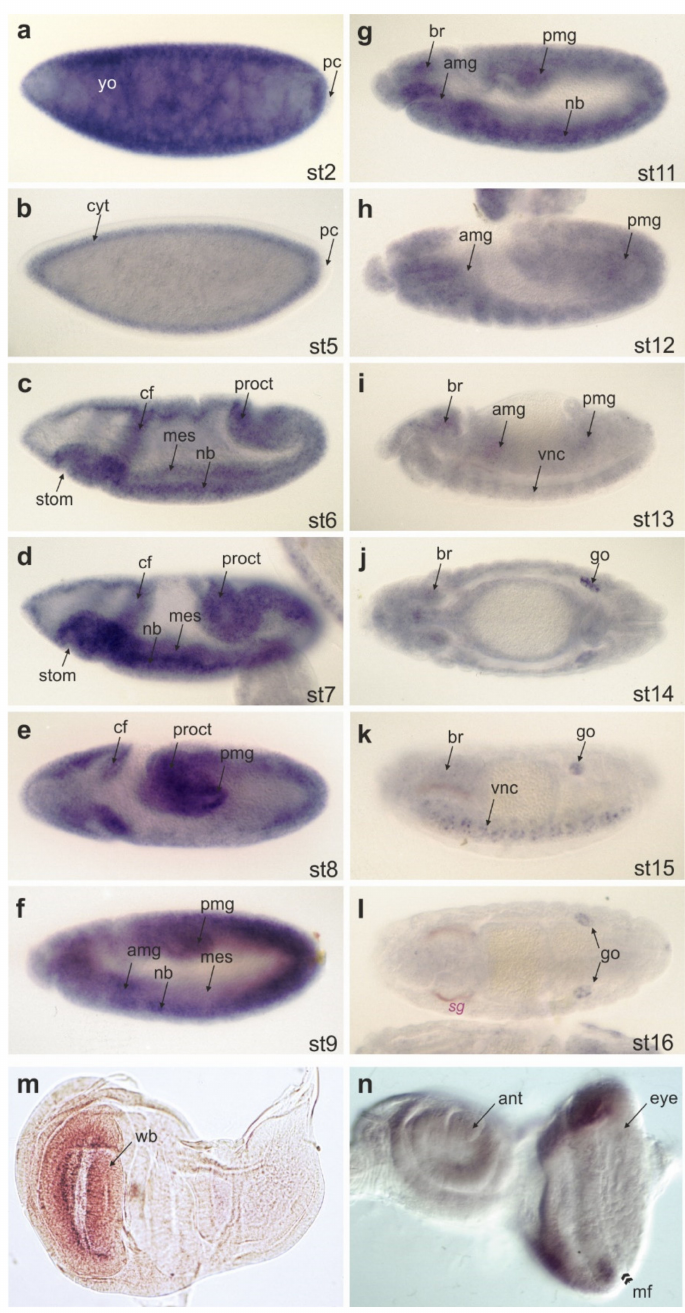
Figure 4. Expression of CG32521 during development. In situ hybridization to detect CG32521 transcription during development. ( a – l ) Embryos are oriented anterior to the left and dorsal up except for the top view in ( j ) and ( l ); developmental stages (st) are indicated. Note enrichment in the yolk (yo) ( a ), the mesoderm (mes) ( c – f ), the developing central nervous system and the brain (nb, br) ( c – k ), as well as the gonads (go) ( j – l ). In the wing imaginal disc, transcripts accumulate in the presumptive wing blade (wb); arrow in ( m ), whereas in the eye-antennal disc, an accumulation is observed in the proliferating part anterior to the morphogenetic furrow (mf); arrowheads in ( n ). Abbreviations are: amg, anterior midgut; ant, antennal disc; br, brain; cf, cephalic furrow; cyt, cytoplasm; eye, eye disc; go, gonads; mes, mesoderm; mf, morphogenetic furrow; nb, neuroblasts; pc, pole cells; pmg, posterior midgut; proct, proctodaeum; sg, salivary glands; stom, stomodaeum; vnc, ventral nerve chord; wb, wing blade; yo,